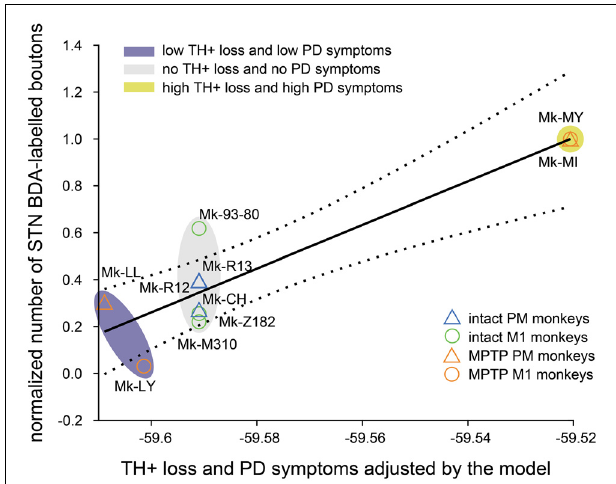
FIGURE 5 | Multivariable linear regression model (see “Materials and Methods” section). Fit (solid black line) and the 95% confidence bounds (black dashed lines) of the constant (number of BDA-labeled boutons) vs. the other variables (PD symptoms and TH+ loss in SNpc) in the model. The multi variables are “partialed out” but not the constant term. Therefore, the X-abscissa represents the combined independent variables (PD symptoms and TH+ loss) adjusted by the model. The model has an explanatory power (positive slope: y = 9.298* x ; R 2 = 0.821; adjusted R 2 = 0.731; p -value = 0.0117). Three clusters (ovals) appear: (1) the highest TH+ loss and motor impairment (yellow); (2) the lowest loss of TH+ neurons and motor impairment (purple) and (3) the intact animal cluster (gray) without dopaminergic loss nor PD symptoms.